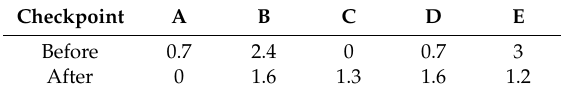
Figure 16. Porta Solestà—PMV tomographies. ( a ) Before intervention; ( b ) after intervention (see Table 2). Table 2. Porta Solestà—PMV before and after.